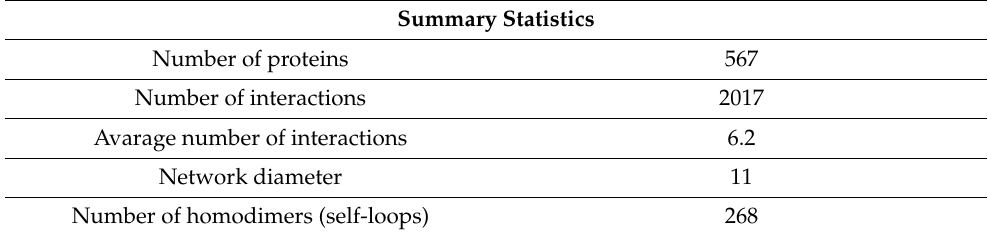
Figure 1. ( A ) Network graph of the protein–protein interactions (PPIs) in human myelin. Nodes represent proteins and edges, protein interactions. ( B ) The distribution of interactions for the proteins in the human myelin network. Table 1. Main statistics of the myelin PPI